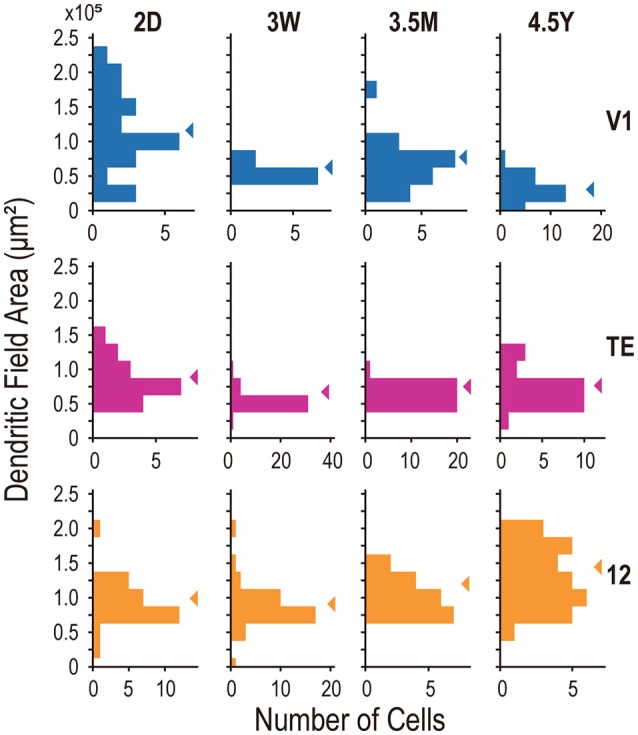
Frequency histograms of the basal dendritic field area of layer V neurons from areas V1, TE, and 12. Arrowheads indicate the medians.